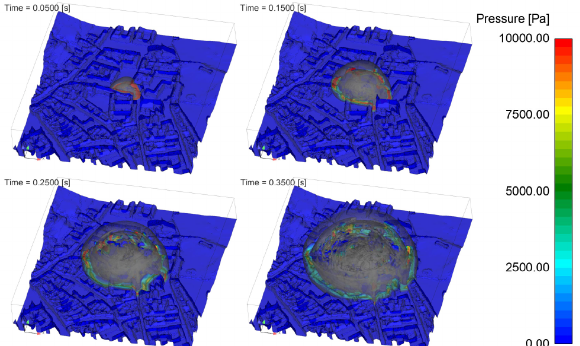
Figure 7. Estimation of the expected pressure propagation over time for 1000 kg of TNT equivalent.